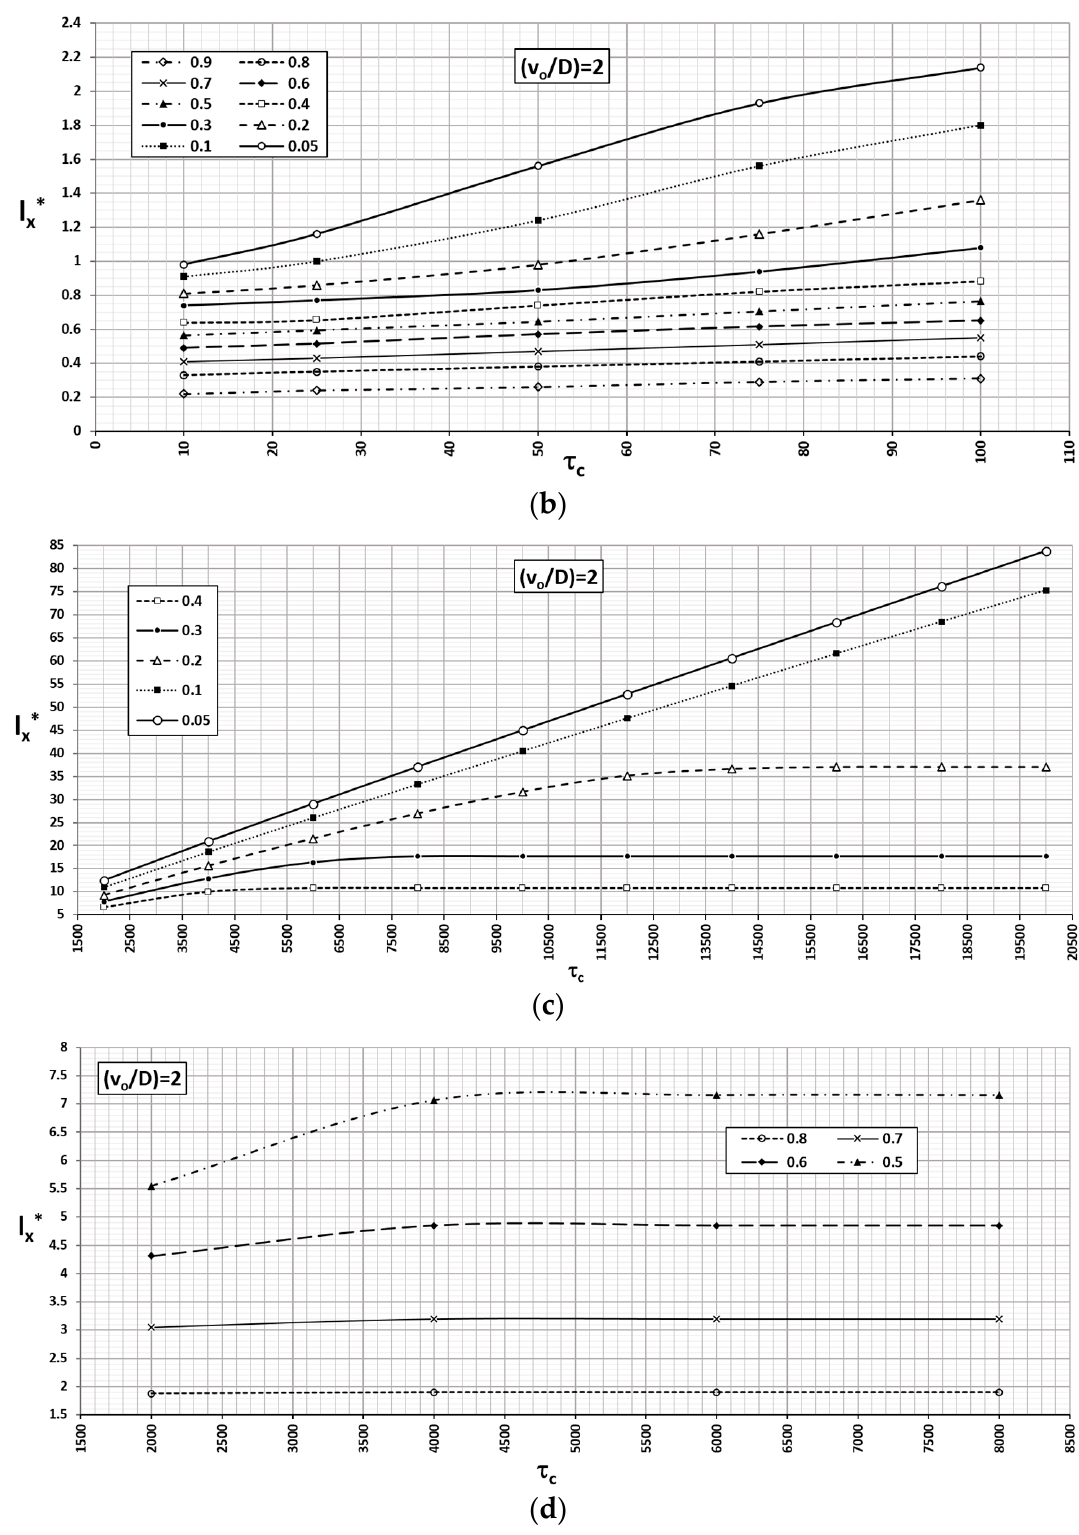
∗ as a function of time factor τ as a function of time factor τ c . Parameter of the abacus v o (cid:2934)((cid:2913) (cid:4594) ) x ( c (cid:48) )